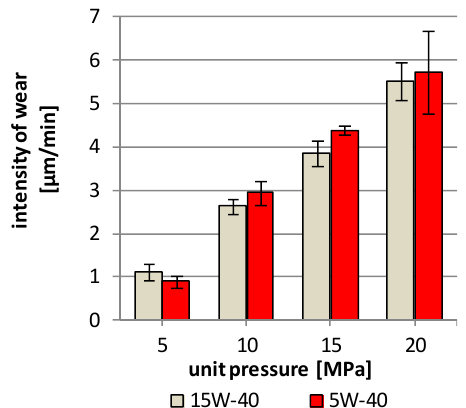
Figure 7. Intensity of wear of SAE-48 bearing alloy during lubrication by engine oils (at 100 rpm).